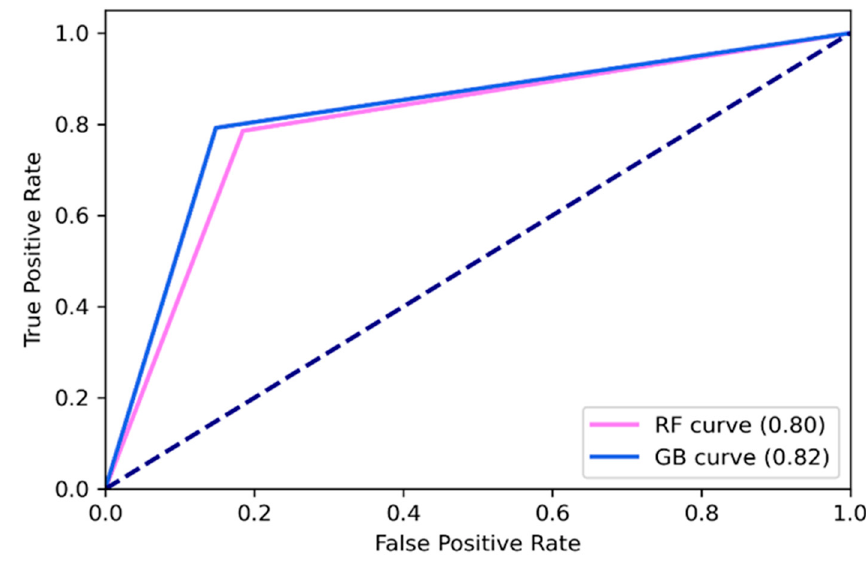
Figure 3. Receiver operating characteristic curve for Random Forest (RF) and Gradient boosting trees (GB).